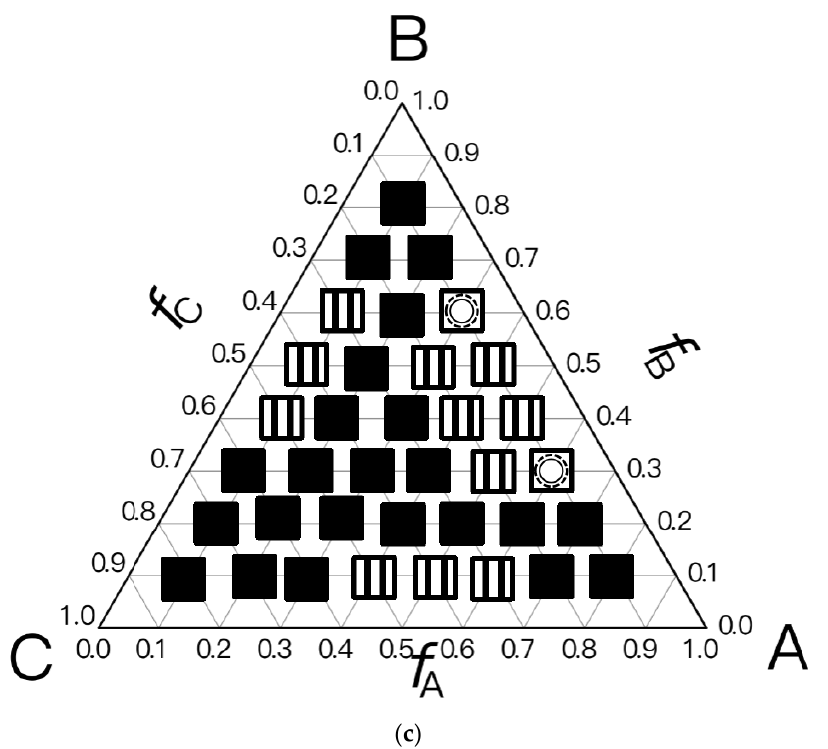
Figure 2. The triangle phase diagrams for the Janus double-brush copolymer (AC 2 B) n containing n subunits in its sequence at different segregation strengths 𝜒 AB 𝑁 = 𝜒 BC 𝑁 = 𝜒 AC 𝑁 = 𝜒𝑁 . ( a ) Architectural periodicity n = 1 and segregation strength 𝜒𝑁 = 35 ; ( b ) n = 2 and 𝜒𝑁 = 35 ; ( c ) n = 1 and 𝜒𝑁 = 35/2 = 17.5 .